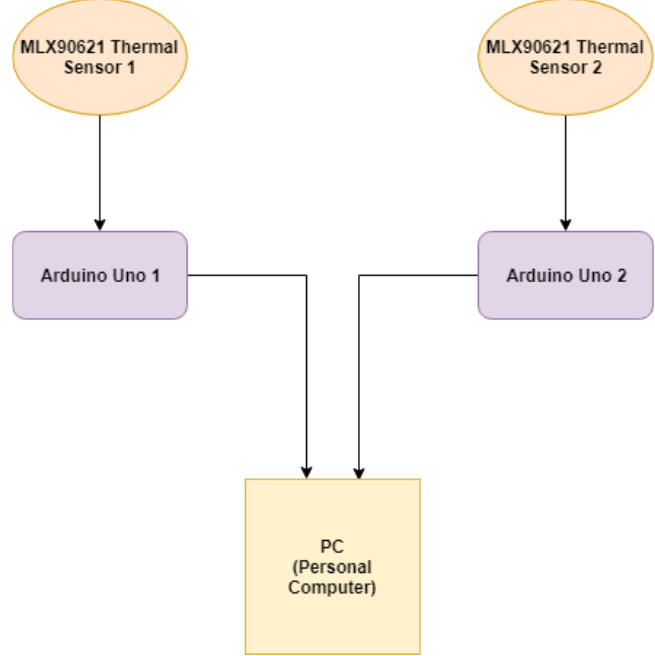
Figure 4. Data flow block diagram using two